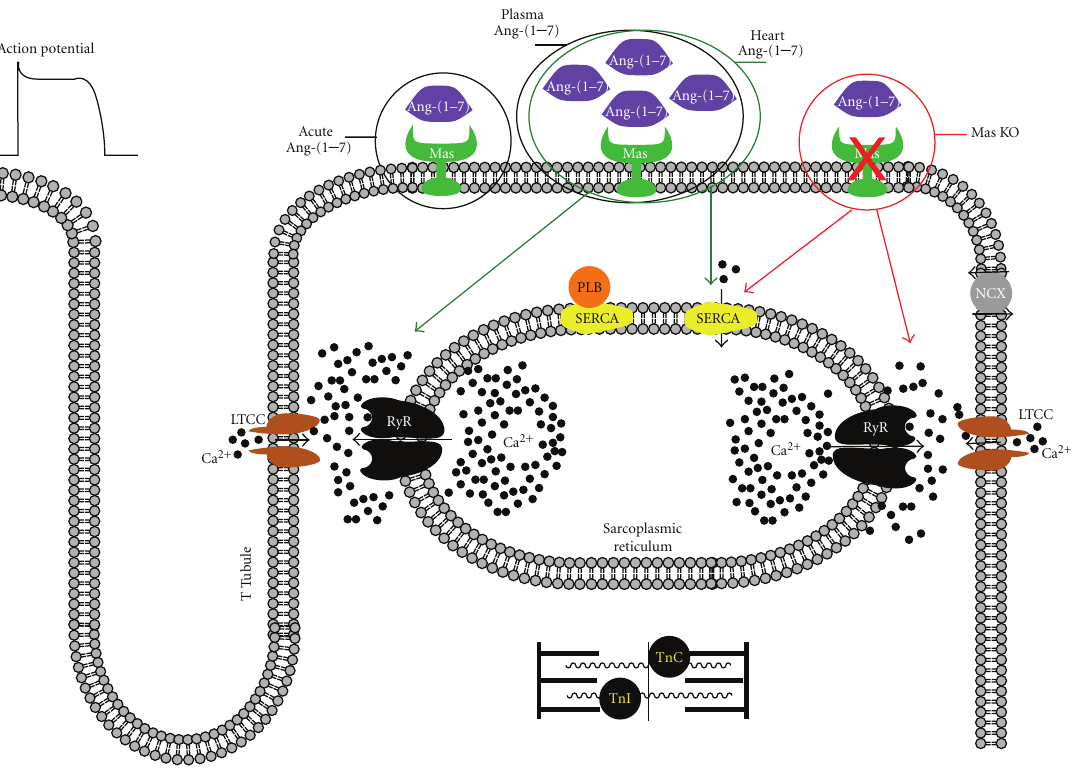
Figure 4: Summary of current knowledge regarding Ang-(1-7) modulation of Ca 2+ handling in ventricular myocytes and the underlying mechanisms. Acute treatment of cardiomyocytes with Ang-(1-7) apparently has no direct e ff ect on Ca 2+ handling (black circle, left). Lack of e ff ect on Ca 2+ levels was also observed in cardiomyocytes from TG rats with increased circulating levels of Ang-(1-7) (black circle, middle). In contrast, Ang-(1-7) signaling disruption through Mas genetic ablation (Mas KO) leads to Ca 2+ dysfunction (red circle, right). Cardiomyocytes from Mas KO mice present reduced SERCA expression levels and Ca 2+ transients (red arrows). Cardiac specific overexpression of Ang-(1-7) enhances Ca 2+ release and SERCA levels in ventricular myocytes (green circle and arrows). Data regarding Ang-(1-7) modulation of some other key proteins involved in Ca 2+ handling in ventricular myocytes, such as PLN, NCX, TnI, and TnC, are still missing. Black filled circles = calcium ions; LTCC = L-type Ca 2+ channels; Mas = Mas receptor; NCX = Na + /Ca 2+ exchanger; PLB = phospholamban; RyR = ryanodine receptor; TnC = troponin C; TnI = troponin